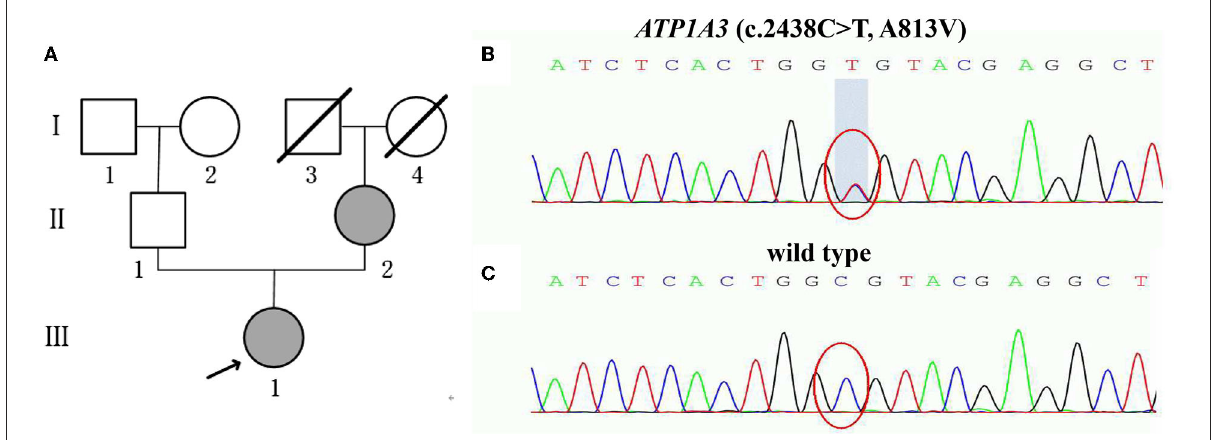
FIGURE1 (A) Pedigree of the family with RDP showing the affected cases (fully shaded: indicate the ATP1A3 (c.2438C > T, A813V) mutation; (B,C) Sanger sequencing analysis of the mutation A813V; (B) Heterozygous p.A813V mutation carrier (the proband III-1 and the mother of the proband II-2); (C) Normal control (the father of the proband